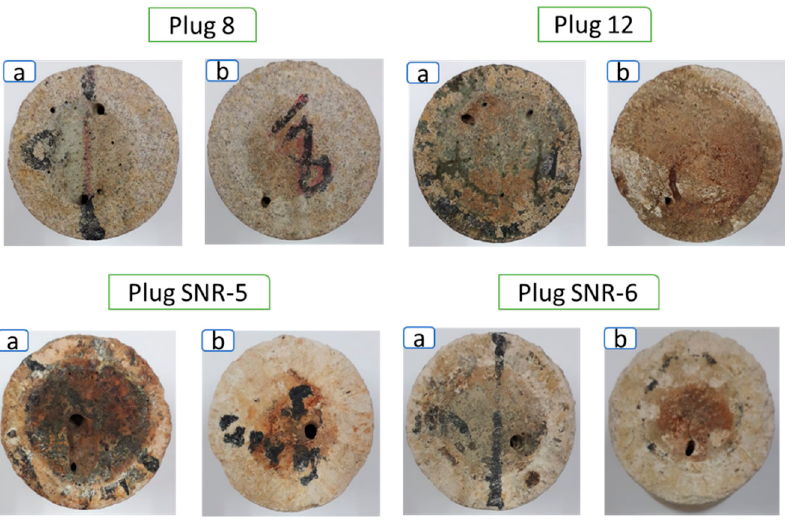
Figure 5. Wormhole-propagation tests ( a ) Core inlet (left); ( b ) outlet (right) after CO 2 foamed acid injection.